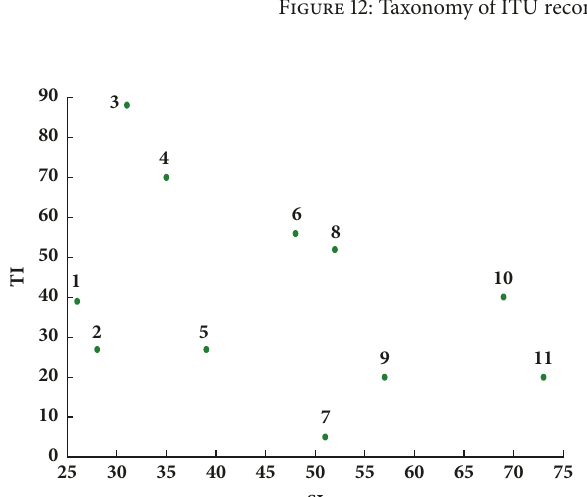
Figure 12: Taxonomy of ITU recommendations related to video streaming.